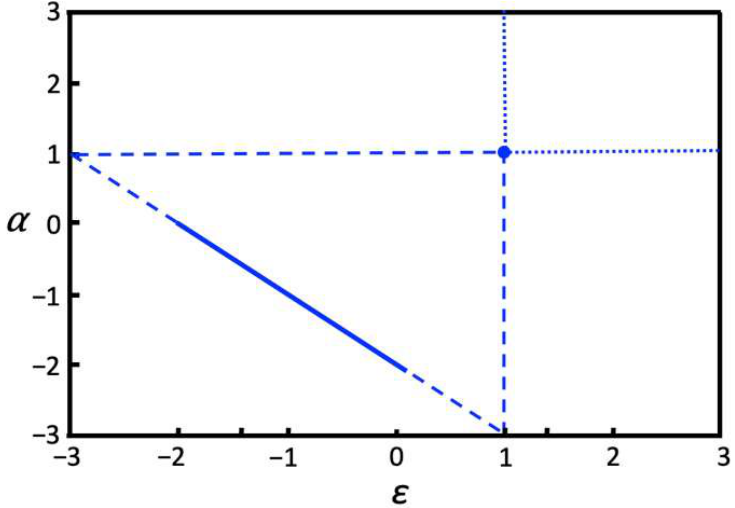
Figure 6. Two-parameter bifurcation diagram for the interaction scheme shown in Figure 1b. The solid line, α = − ε − 2 for − 2 < ε < 0, shows the parameter values where both 𝑃(cid:4652)⃗ = (𝑝 (cid:2869) ,𝑝 (cid:2870) ,𝑥 (cid:2869) ,𝑥 (cid:2870) ) and 𝑄(cid:4652)⃗ = (𝑞 (cid:2869) ,𝑞 (cid:2870) ,𝑦 (cid:2869) ,𝑦 (cid:2870) ) oscillate and the relationships between 𝑝 (cid:2869) and 𝑝 (cid:2870) and 𝑞 (cid:2869) and 𝑞 (cid:2870) are maintained over time. For these parameter values, 𝑃(cid:4652)⃗ and 𝑄(cid:4652)⃗ oscillate out of phase and with varying amplitudes. Dashed lines show the parameter values where oscillations exist but either the relationships between p-processes or q-processes are no longer maintained (diagonal dashed lines), or only one set of processes oscillate while another set of processes does not exhibit oscillatory dynamics (vertical and horizontal dashed lines). Dotted lines show parameter ranges where oscillations exist only if either 𝑃(cid:4652)⃗ or 𝑄(cid:4652)⃗ starts with zero initial conditions and, thus, only p-processes or q-processes oscillate, which is equivalent to the situation when 𝑃(cid:4652)⃗ and 𝑄(cid:4652)⃗ are decoupled and independent. At the point ( α = 1, ε = 1), both p-processes and q-processes oscillate in phase with constant amplitudes.